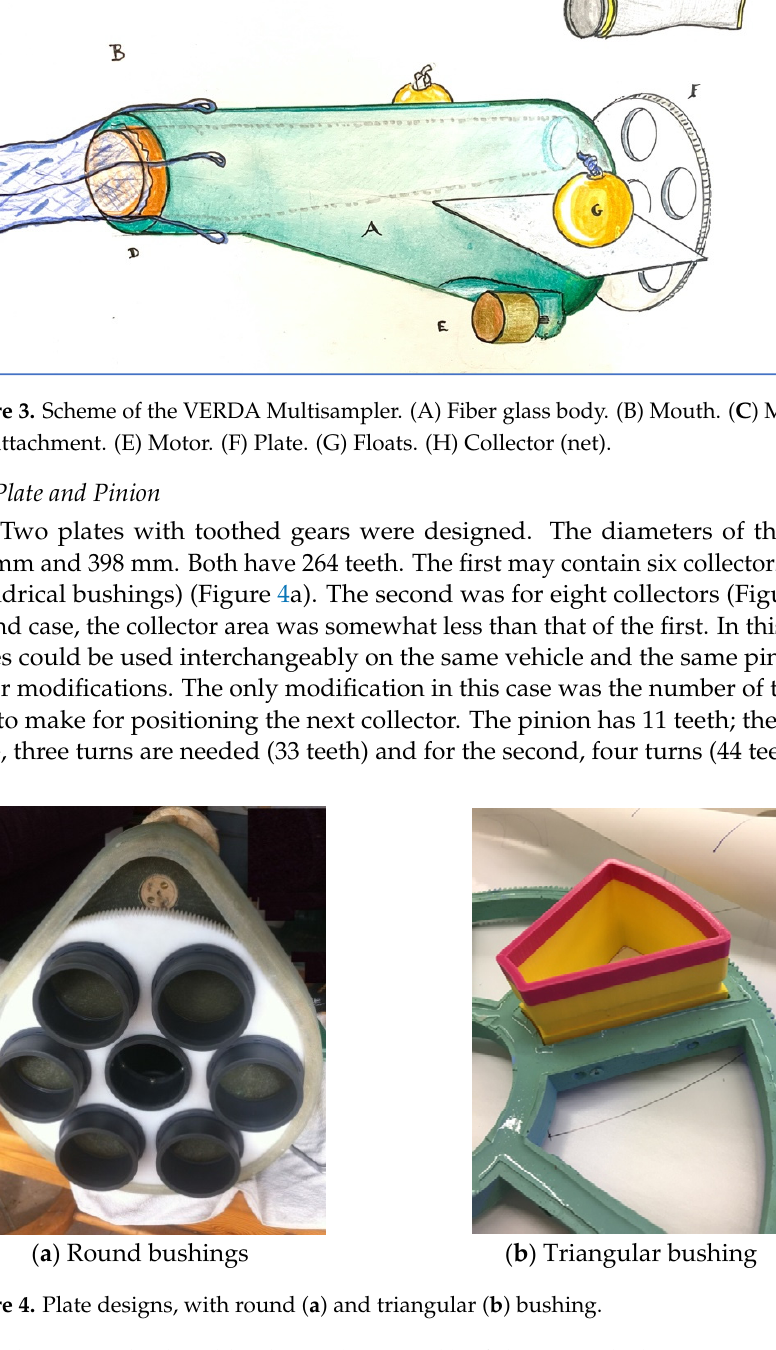
Figure 2. View, in inverted position, of vehicle without the casing. Observe the way collector bags are attached to sea anchor rope.